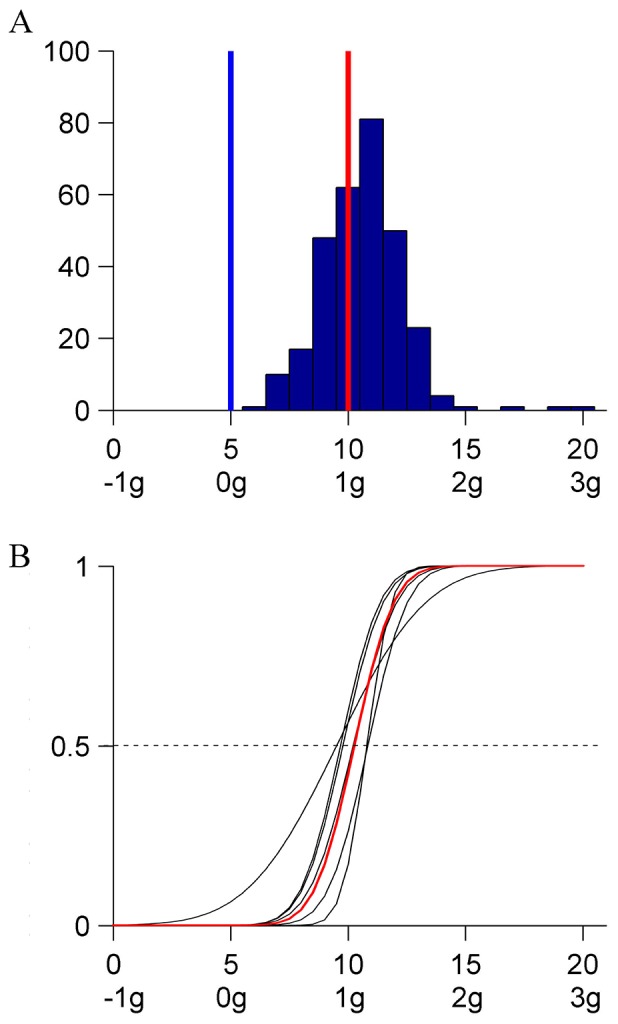
Experiment 6 (0° orientation, with eye fixation).A: Distribution histogram of the responses (pooled over participants). B: CDFs for each participant and for the population. Same format as in Figure 2B.